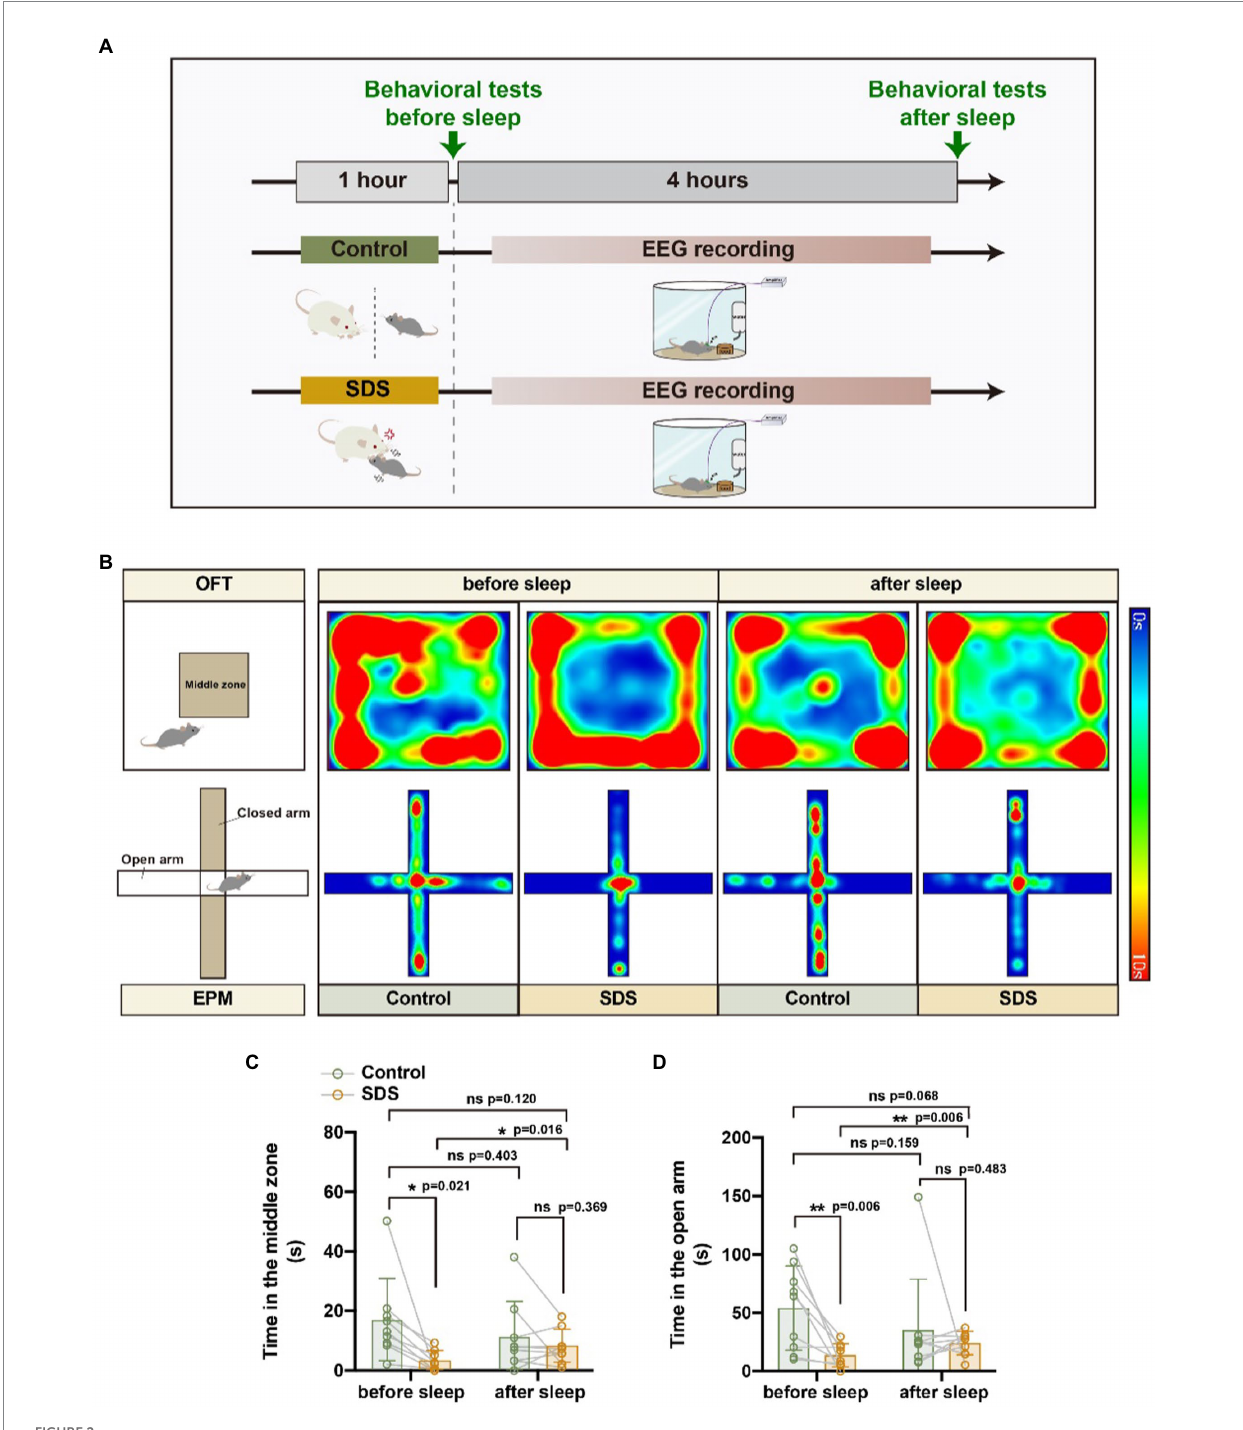
FIGURE 2 SDS induced anxiety-like behavior, whereas sleep reduced anxiety in APP/PS1 mice. (A) Schematic diagram of non-SDS and SDS groups. (B) Representative heatmaps of trajectories in OFT and EPM before and after EEG recording in non-SDS and SDS groups. (C,D) Quantitative analysis of OFT and EPM in control and SDS groups. n = 9, paired t